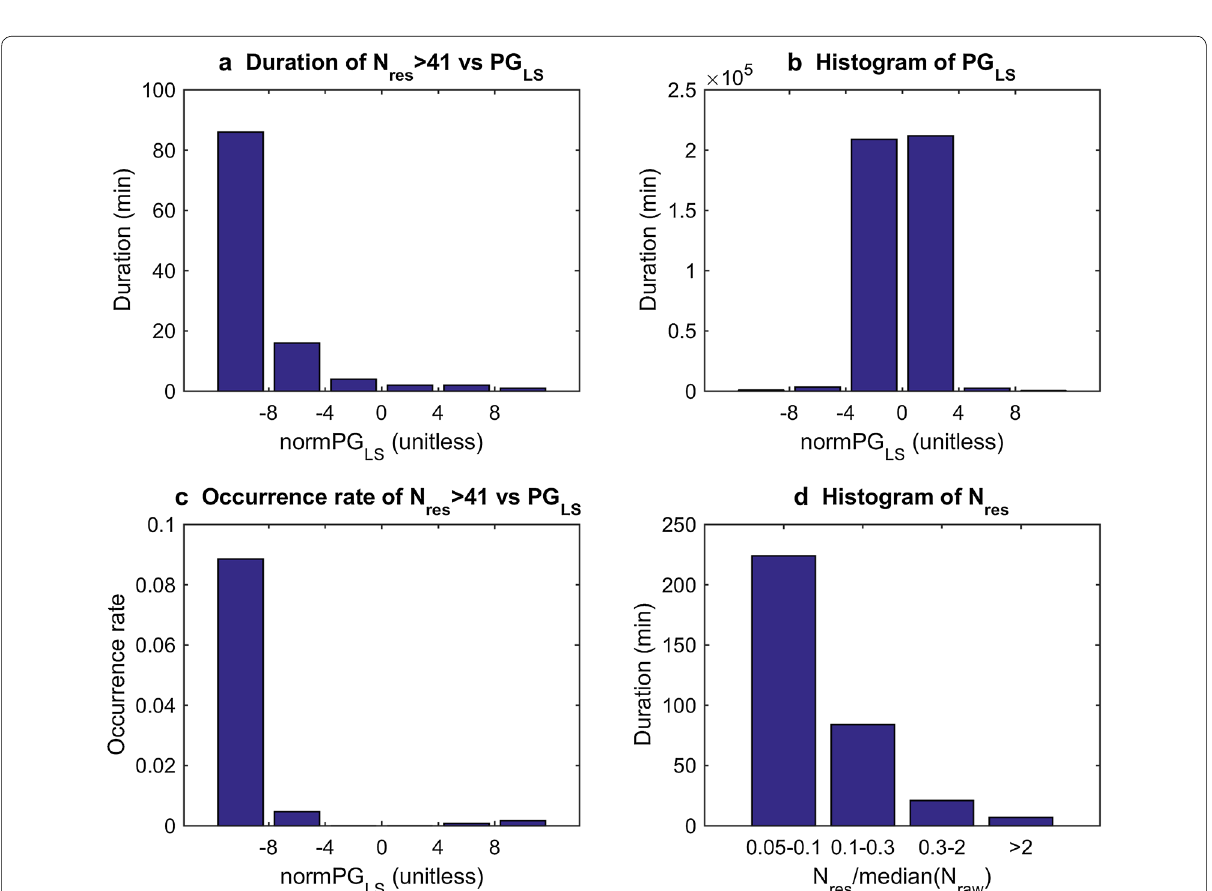
Fig. 3 Histograms summarizing the observation at LS. a Number of minutes when N res > 41 ( N raw /10) for specific intervals of normalized PG. b Total duration of PG values in specific intervals. c Occurrence rate of N res > 41 ( N raw /10) for various intervals of normalized PG. d Duration of enhancements in dependence on their relative values N res /median( N raw